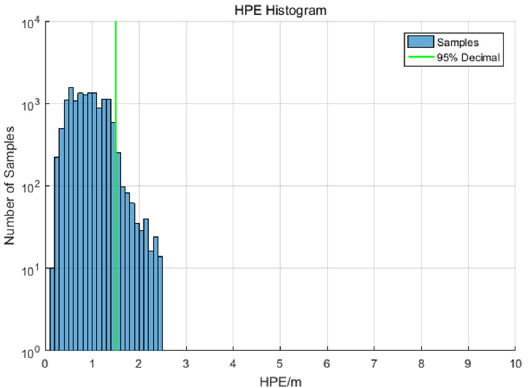
Figure 20. The HPE histogram of flight test-III. The green line in the figure is the horizontal accuracy (95%), which is 1.49 m.